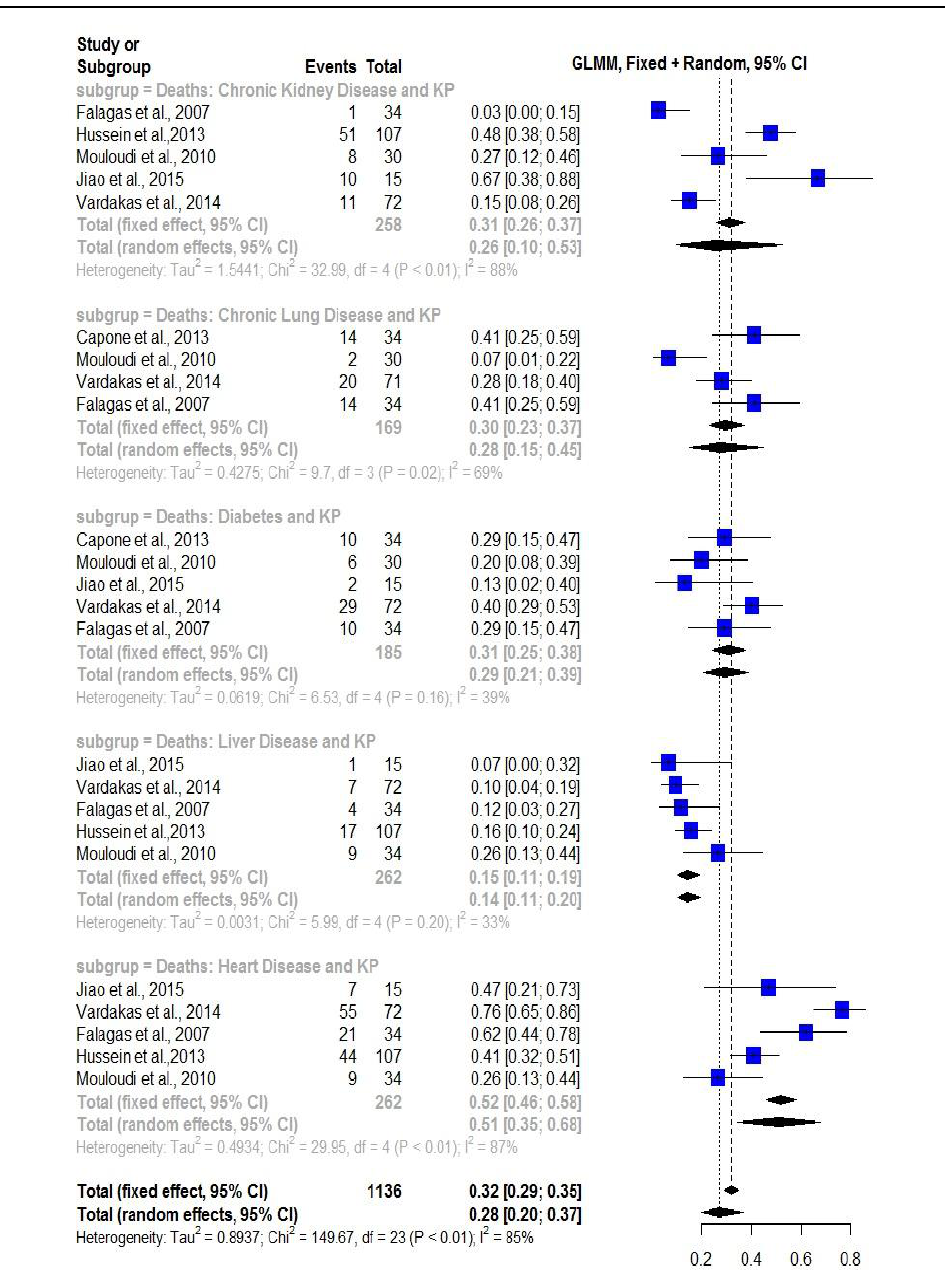
Figure 1. Test for proportion determination with a mixed generalized linear model (GLMM): Mortality ratio of patients with comorbidities associated with K. pneumoniae .